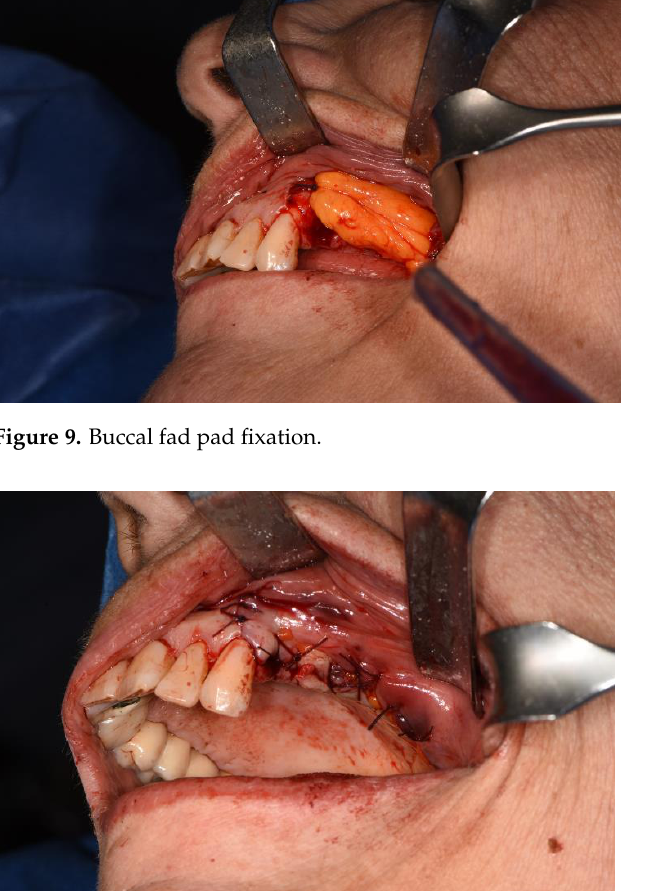
Figure 10 Double layer flap sutured.